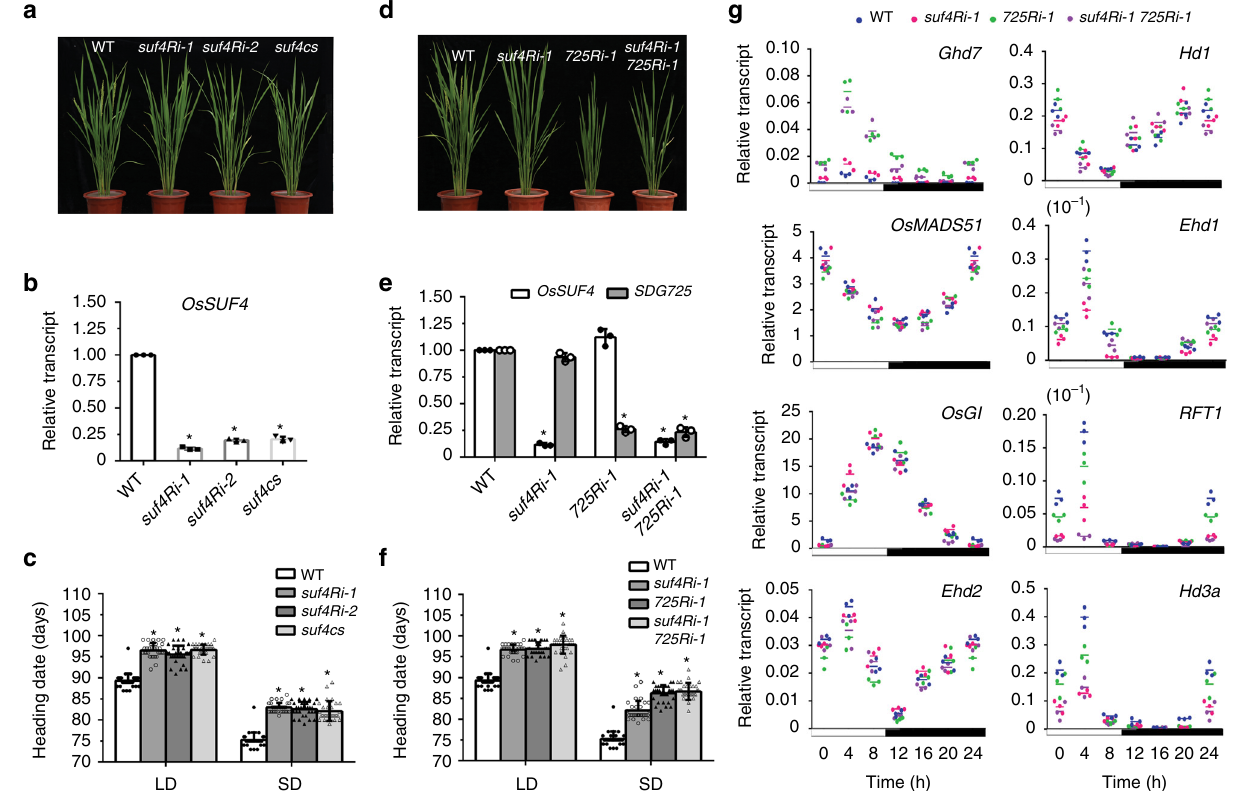
Fig. 3 OsSUF4 promotes rice fl owering under both LD and SD conditions. a Overall morphologies of 10-week-old wild-type (WT), two independent OsSUF4 RNAi lines suf4Ri-1 and suf4Ri-2 , and OsSUF4 co-suppressed ( suf4cs ) rice plants under SD conditions. b Relative transcript levels of OsSUF4 in WT, suf4Ri-1 , suf4Ri-2 , and suf4cs plants under SD conditions. c Heading date of WT, suf4Ri-1 , suf4Ri-2 , and suf4cs plants grown in paddy fi elds under LD (Shanghai)